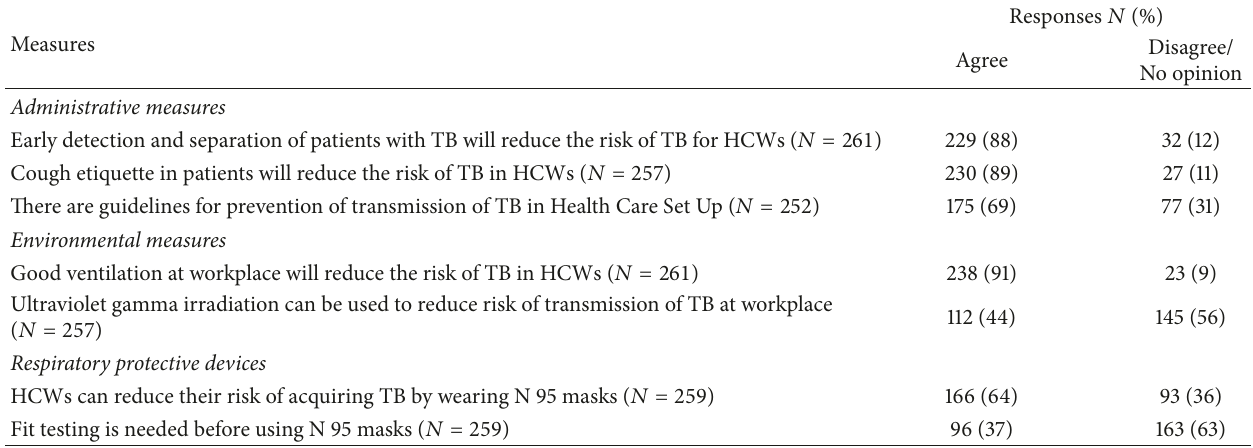
Table 2: Knowledge about measures to prevent occupationally acquired tuberculosis amongst medical resident doctors.